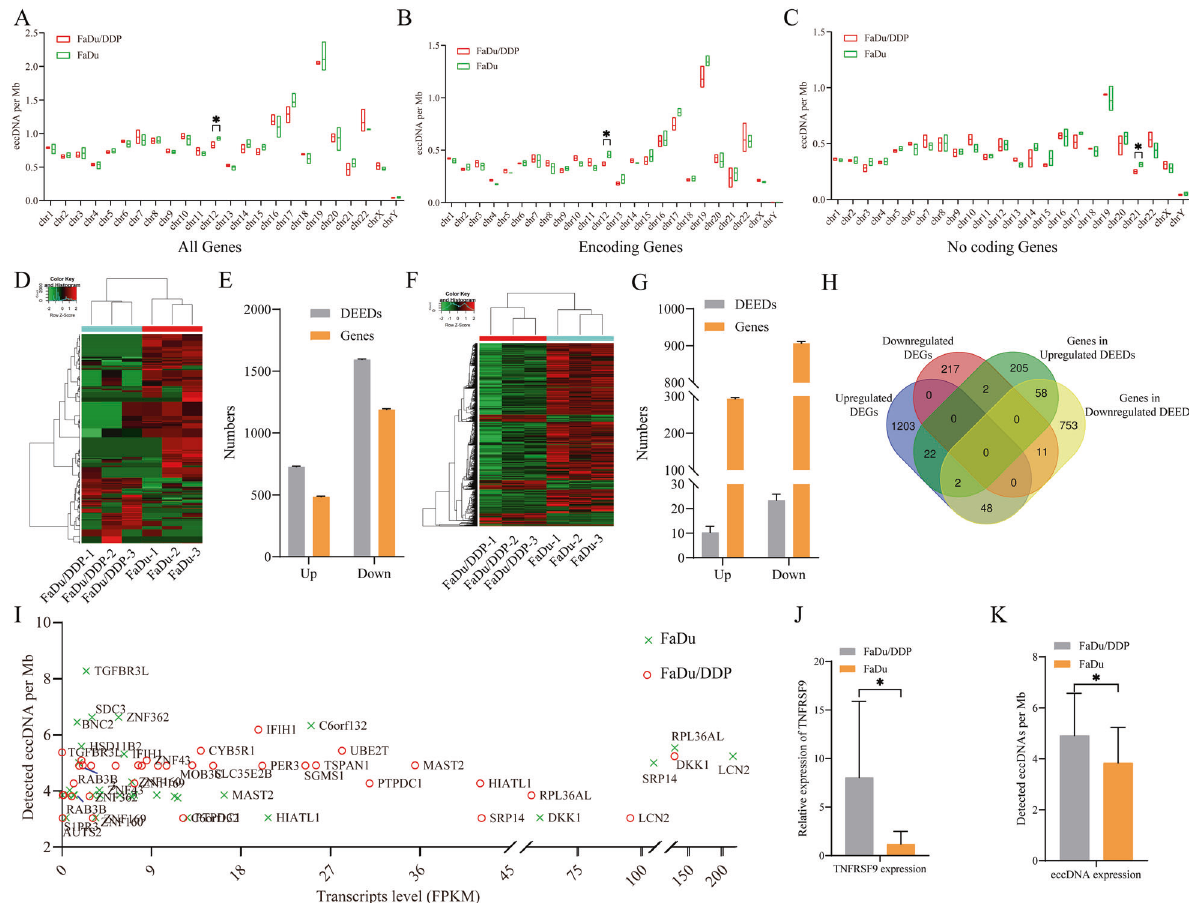
Fig. 2 Differentially expressed eccDNAs and genes. A Whole genome-wide eccDNA expression is shown by chromosome grouping, as inferred from FaDu/DDP cells compared to FaDu cells. B Whole genome-wide eccDNA expression amplifying encoding genes is shown in grouping by chromosome, as inferred from FaDu/DDP cells compared to FaDu cells. C Whole genome-wide eccDNA expression amplifying no genes is shown in grouping by chromosome, as inferred from FaDu/DDP cells compared to FaDu cells. D Cluster heat map shows the DEEDs between FaDu/DDP cells and FaDu cells. E Number of DEED types and amplifying genes in FaDu/DDP cells and FaDu cells. F Cluster heat map shows the DEGs between FaDu/DDP cells and FaDu cells. G Number of DEED-amplifying complete encoding genes and corresponding encoding genes in FaDu/DDP cells and FaDu cells. H Venn diagram shows the signi fi cant overlapping genes between the complete encoding genes carried by DEEDs and DEGs. I EccDNA counts per gene relative to the average transcription level of FaDu/DDP cells and FaDu cells. J Relative mRNA expression ( z scores) of TNFRSF9 between FaDu/DDP cells and FaDu cells. K Relative eccDNA expression (counts) of [ TNFRSF9 circle exon 1-9 ] between FaDu/DDP cells and FaDu cells; * p < whether there was a change in the content of eccDNA between FaDu/DDP and FaDu cells. To further study the differential expression of eccDNAs between FaDu/DDP and FaDu cells, edgeR (v0.6.9) software was used to perform normalization and differentially expressed eccDNAs (DEEDs) fi ltering by p value and fold change. Eventually, a total of 2307 DEEDs were preliminarily screened with 1163 eccDNA ampli fi ed genes with a threshold of |log2FC | >1 and adjusted p < 0.05. Compared with the FaDu cells, 720 DEEDs together with 480 genes and 1587 DEEDs together with 1183 genes were upregulated and downregulated in the FaDu/DDP cells, respec- tively (Fig. 2D, E, Supplementary Table 4). Furthermore, the GO and pathway enrichment analyses were performed based on the differentially expressed eccDNA- associated encoding genes. The results of the GO analysis revealed that the upregulated DEEDs ampli fi ed genes were enriched in CC terms (voltage-gated sodium channel complex, and apical plasma membrane), MF terms (voltage-gated sodium channel activity, and retinoic acid binding) and BP terms (negative regulation of glucuronosyltransferase activity, and negative regulation of cellular glucuronidation). The downregulated DEEDs